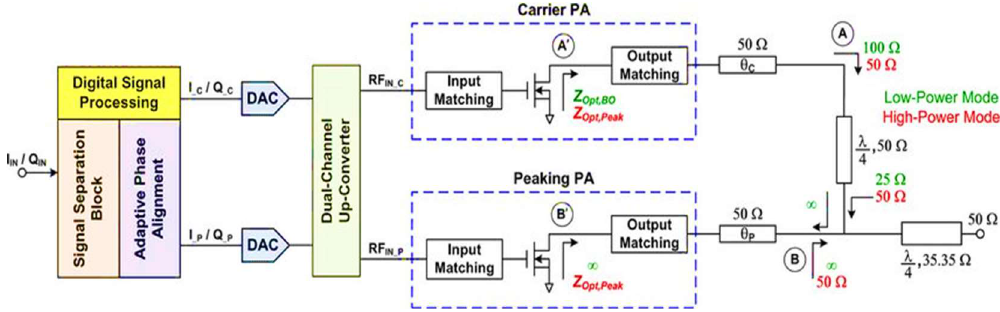
Figure 9. Block diagram of the dual-input digital Doherty PA architecture [62].